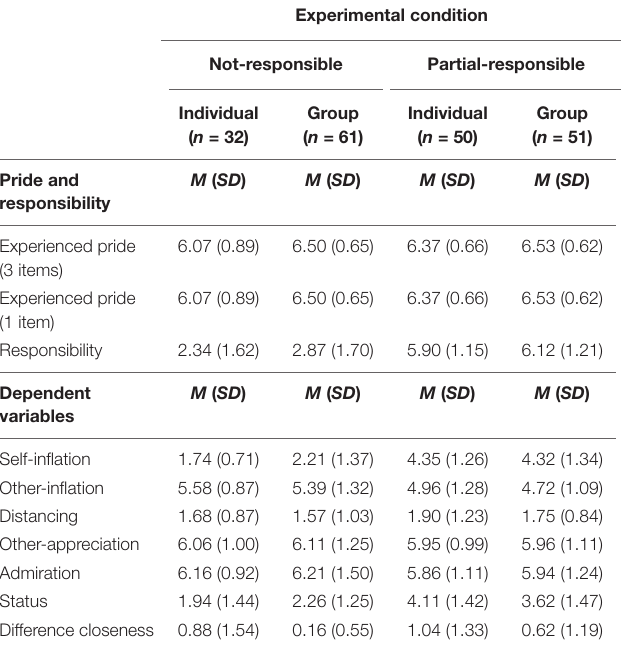
TABLE 3 | Means and standard deviations of all dependent variables in Experiment